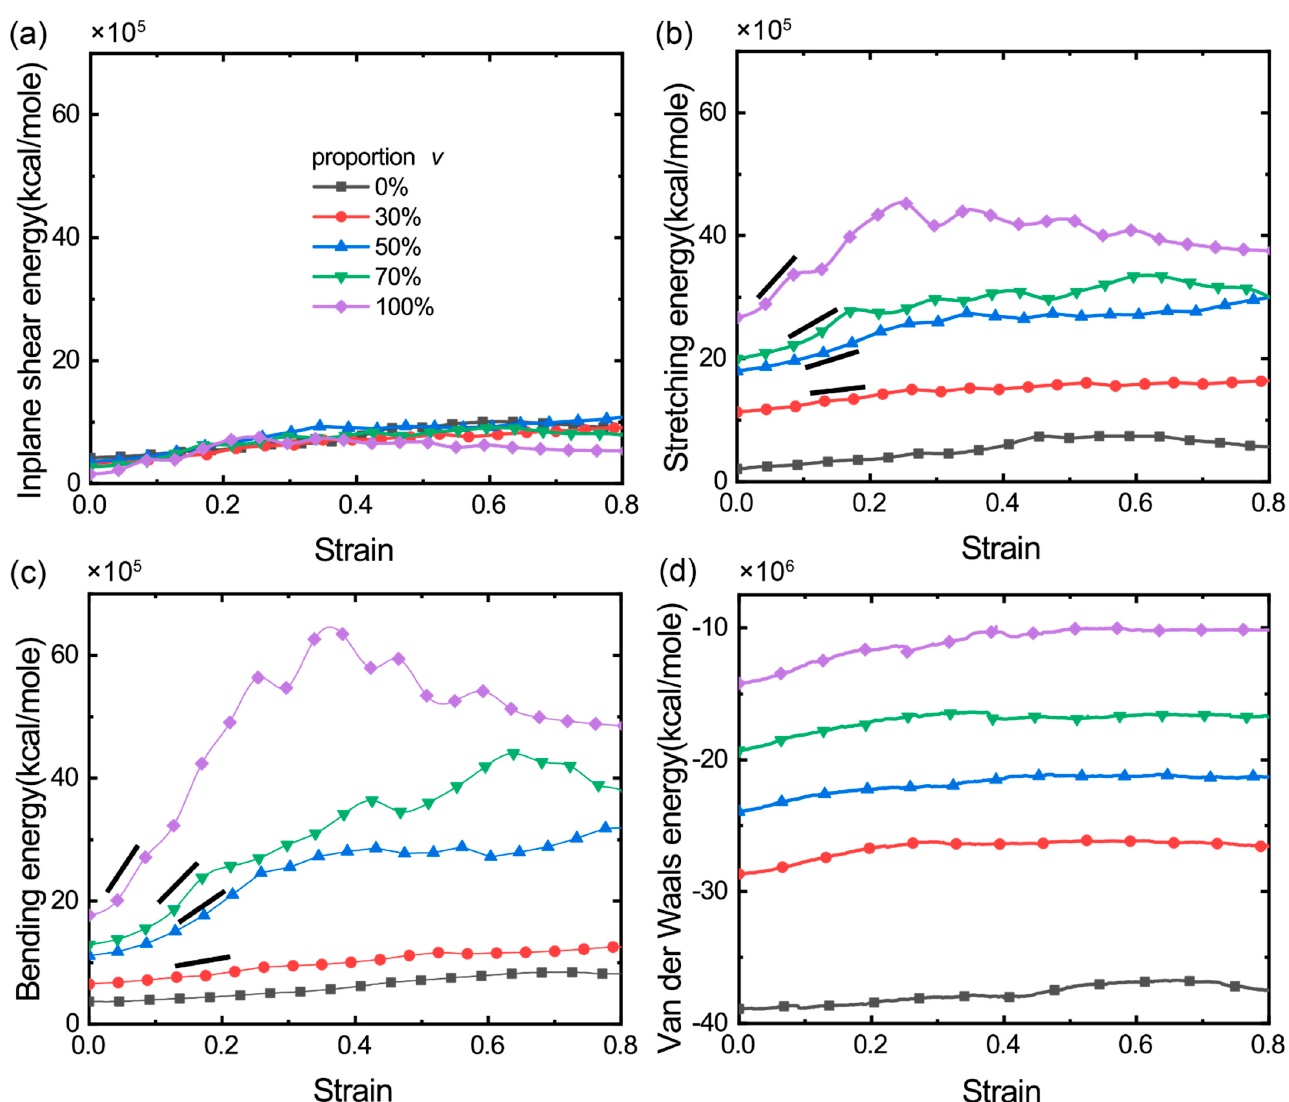
Figure 3. The distribution and evolution of three deformation energies, of stretching ( a ), in-plane shearing ( b ) and out-of-plane bending ( c ) of sheets, and the van der Waals potential energy ( d ) between neighboring sheets.